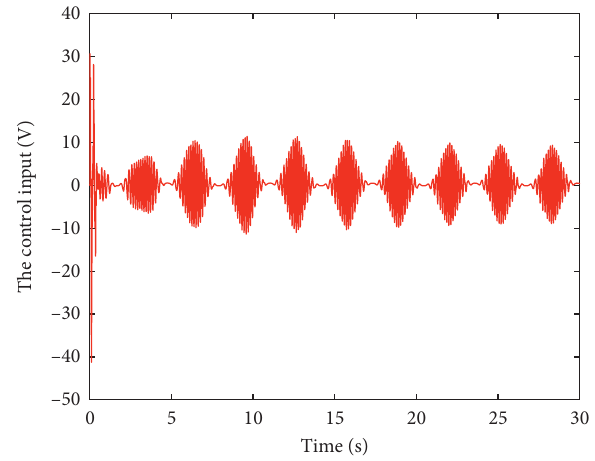
Figure 10: The trajectory of the controller input.